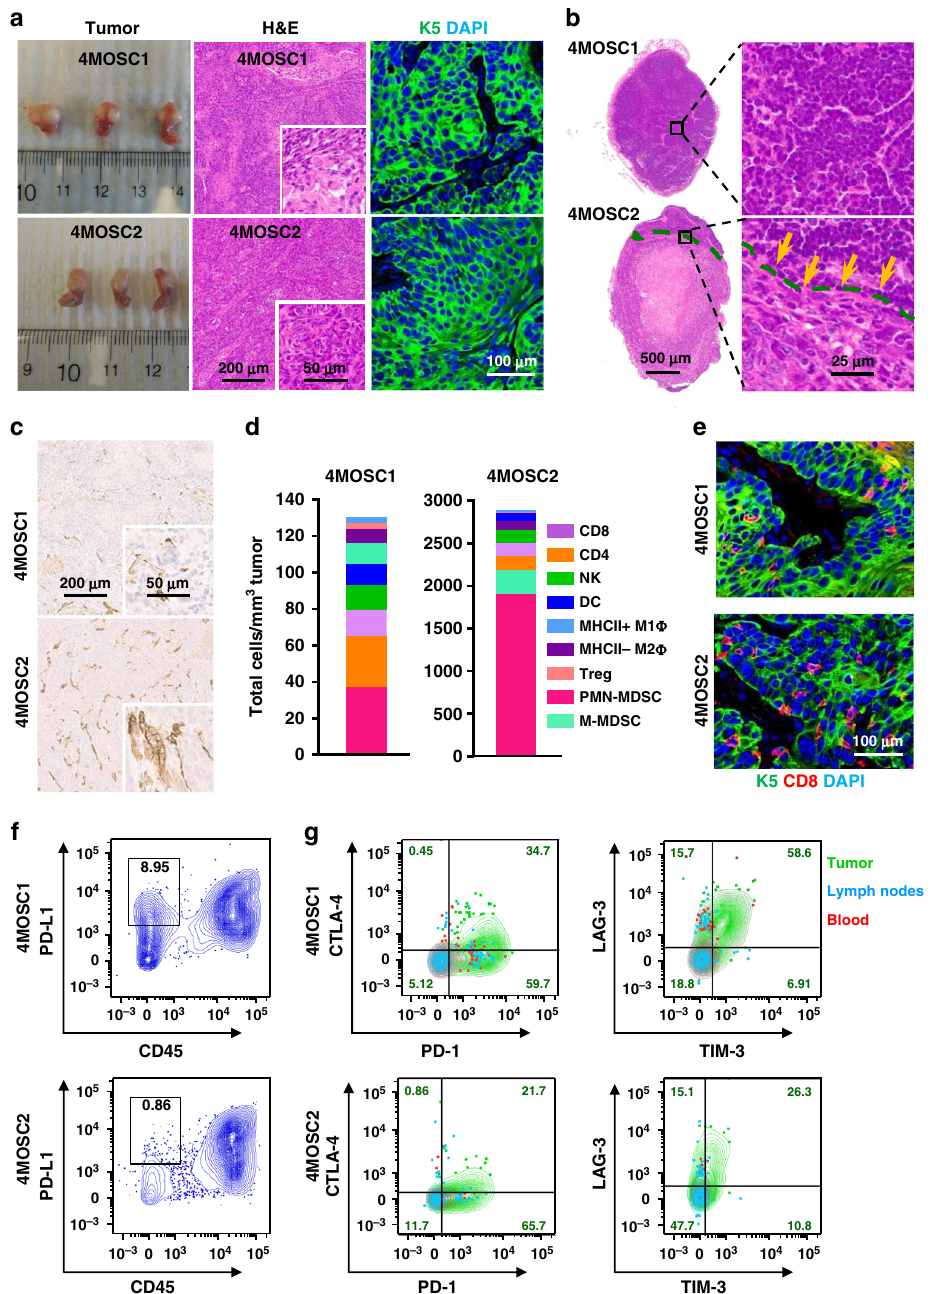
Fig. 2 Characterization of 4NQO-induced murine oral squamous cell model. a Left panel, C57Bl/6 mice were implanted with 1 × 10 6 of either 4MOSC1 or 4MOSC2 cells into the tongue. Tongue lesions when the tumor volume reached ~100 mm 3 . Middle panel, representative H&E staining of histological tissue sections from mouse tongues with 4MOSC1 or 4MOSC2 tumors. Right, representative pictures of tumors stained to show expression of cytokeratin 5 (CK5, green) and DAPI (blue) ( n = 3 mice per group). b Top panel, representative H&E stain of a nonmetastatic cervical lymph node from mice with 4MOSC1 tumors. Bottom panel, representative H&E stain of a metastatic cervical lymph node from mice with 4MOSC2 tumors. Metastatic growth of 4MOSC2 cells into the lymph node is depicted with a dotted line in the bottom area ( n = 5 mice per group). c Representative tumor tissue sections stained for LYVE-1 by immunohistochemistry in 4MOSC1 or 4MOSC2 tumors ( n = 3 mice per group). d Absolute number of immune cells in fi ltrating 4MOSC1 or 4MOSC2 tumors. Shown is the average number of live cells in fi ltrating per mm 3 of tumor ( n = 3 mice per group). e Immuno fl uorescent staining of CK5 and CD8 to show squamous cell character of the lesion and CD8 in fi ltration in mice with 4MOSC1 or 4MOSC2 tumors, respectively ( n = 3 mice per group) (CK5, green; CD8, red; DAPI, blue). 4MOSC1 or 4MOSC2 tumors were isolated from mice and mechanically and enzymatically digested. Single-cell suspension was then stained with CD45, Nk1.1, CD3, CD8, CD44, PD-L1, PD-1, CTLA-4, LAG-3, and TIM-3 fl uorescent labeled antibodies and analyzed by fl ow cytometry. Shown are representative fl ow cytometry plots of f the frequency of tumor cells (CD45 negative) expressing PD-L1 and g the frequency of CD8 + /CD44 + cells expressing inhibitory receptors PD-1, CTLA-4, LAG-3, and TIM-3 in individual tumors ( n = 4 mice per group). Contour plots of lymphocytes from tumor (green), and corresponding cervical lymph nodes (blue), and blood (red) are overlaid and the frequencies of tumor CD8 + /CD44 + T cells expressing each inhibitory receptor are shown ( n = 4 mice per